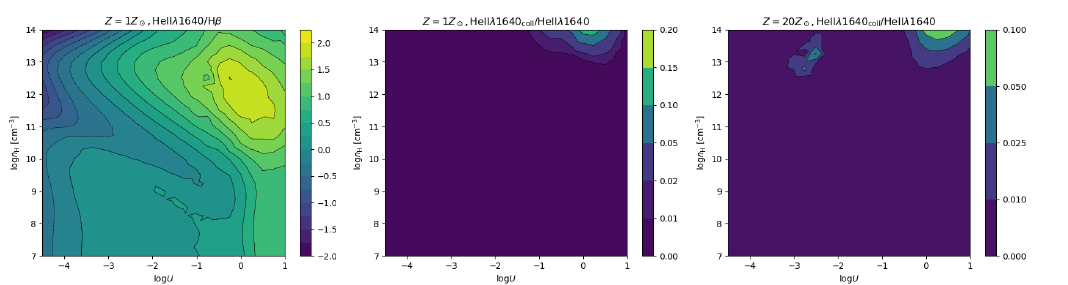
Figure 2. Left panel: the decimal logarithm of the ratio between He II λ 1640 and H β as a function of ionization parameter U and hydrogen density n H , computed as in the previous figure. Middle and right panels: the ratio of collisional excitation emission to total line emission for the He II λ 1640 line, again as a function of ionization parameter U and hydrogen density n H . Left: Z = 1 Z (cid:12) ; right: Z = 20 Z (cid:12) .